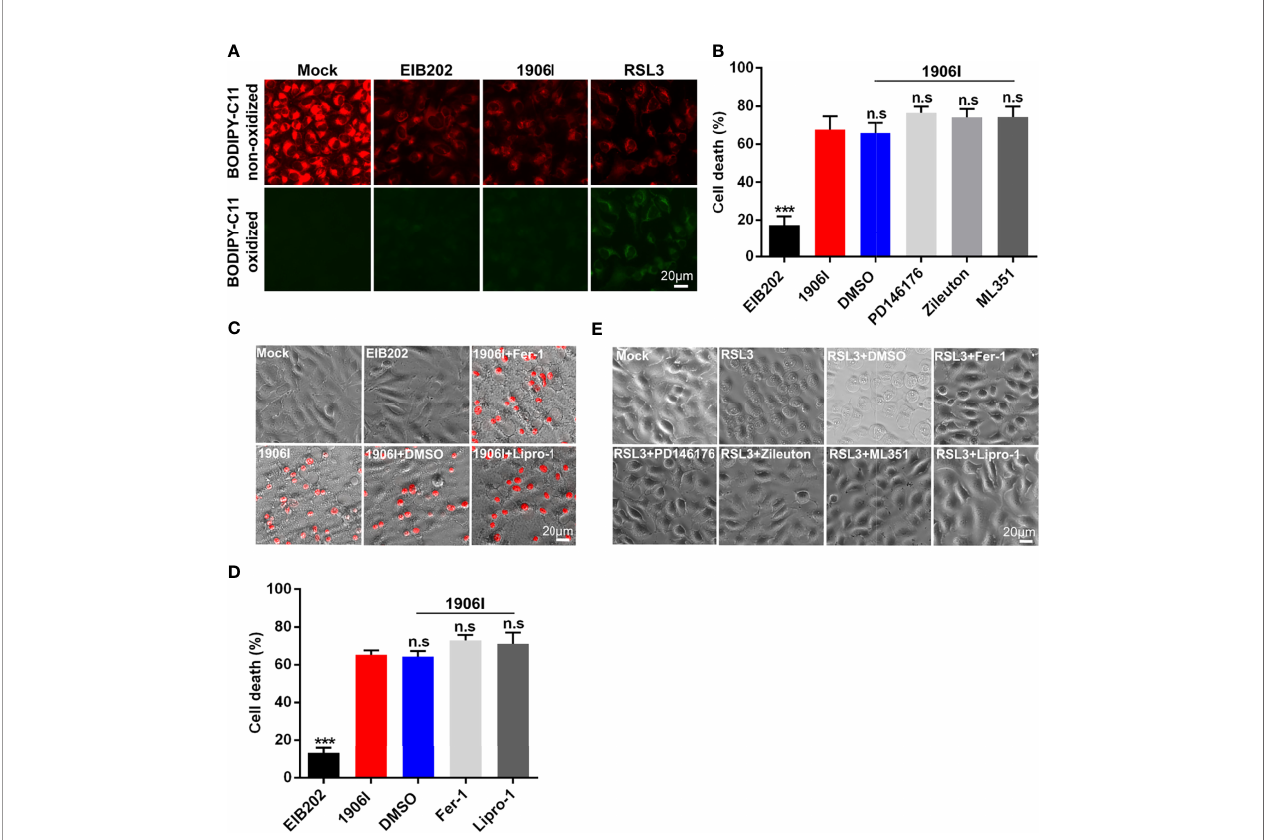
FIGURE 6 | Cell death induced by c-di-GMP-upregulated E. piscicida was independent of lipid peroxidation. (A) Detection of lipid peroxidation by BODIPY-C11 in HeLa cells treated with indicated E. piscicida strains (MOI=25) or RSL3. Fluorescent microscopic images were taken at 3.5 h post bacterial infection or RSL3 treatment. Untreated cells as a negative control and RSL3-treated cells as a positive control. Scale bar, 20 m m. (B) LDH release of HeLa cells infected with E. piscicida EIB202 or 1906I (MOI=25, 5 hpi) in the presence of PD146176 (5 µM), zileuton (5 µM), ML351 (10 µM), or DMSO. (C, D) Cell morphology with PI staining (C) and LDH release (D) of HeLa cells infected with E. piscicida EIB202 or 1906I (MOI=25, 5 hpi) in the presence of ferrostatin-1 (Fer-1, 20 µM), liproxstatin-1 (Lipro- 1, 20 µM), or DMSO. Scale bar for the images, 20 m m. (E) Cell morphology of RSL3-treated HeLa cells with PD146176 (5 µM), zileuton (5 µM), ML351 (10 µM), Fer- 1 (20 µM), lipro-1 (20 µM), or DMSO. Scale bar, 20 m m. Results are representative of at least three independent experiments, and error bars denote SD of triplicate wells. *** P < 0.001; n.s, not signi fi cant. (One-way